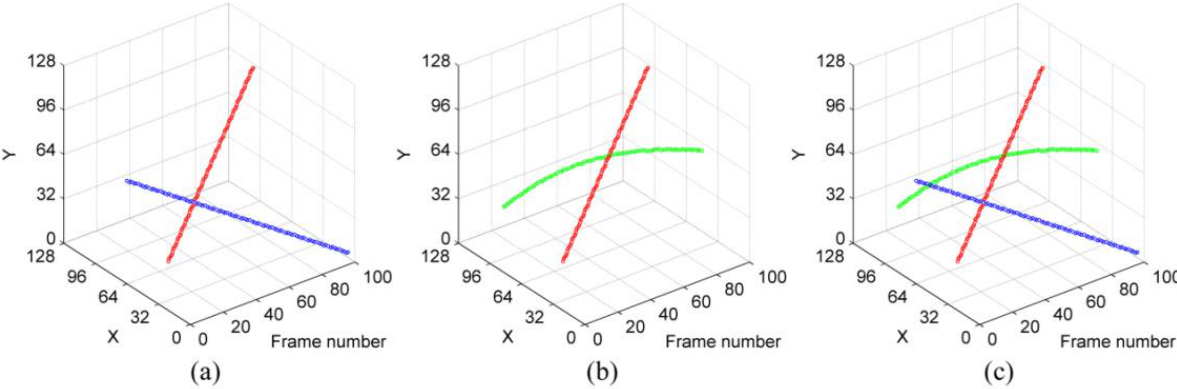
Figure 7. ( a ) Test case 1; ( b ) test case 2; ( c ) test case 3. Straight-line trajectory 1 is marked in red, and its initial coordinates were (24,34) and its motion velocity was (0.8, 0.6) pixel/frame; straight-line trajectory 2 is marked in blue, and it had the initial coordinates of (66, 73) and the motion velocity of (−0.6, −0.7) pixel/frame; the arc trajectory is marked in green, and it had the motion speed of 1 pixel/frame, arc center of (64, 46), and the arc radius of 20 pixels. The two straight-line trajectories intersect at (48, 52), while the straight-line trajectory 1 and arc trajectory intersect at (67, 66).